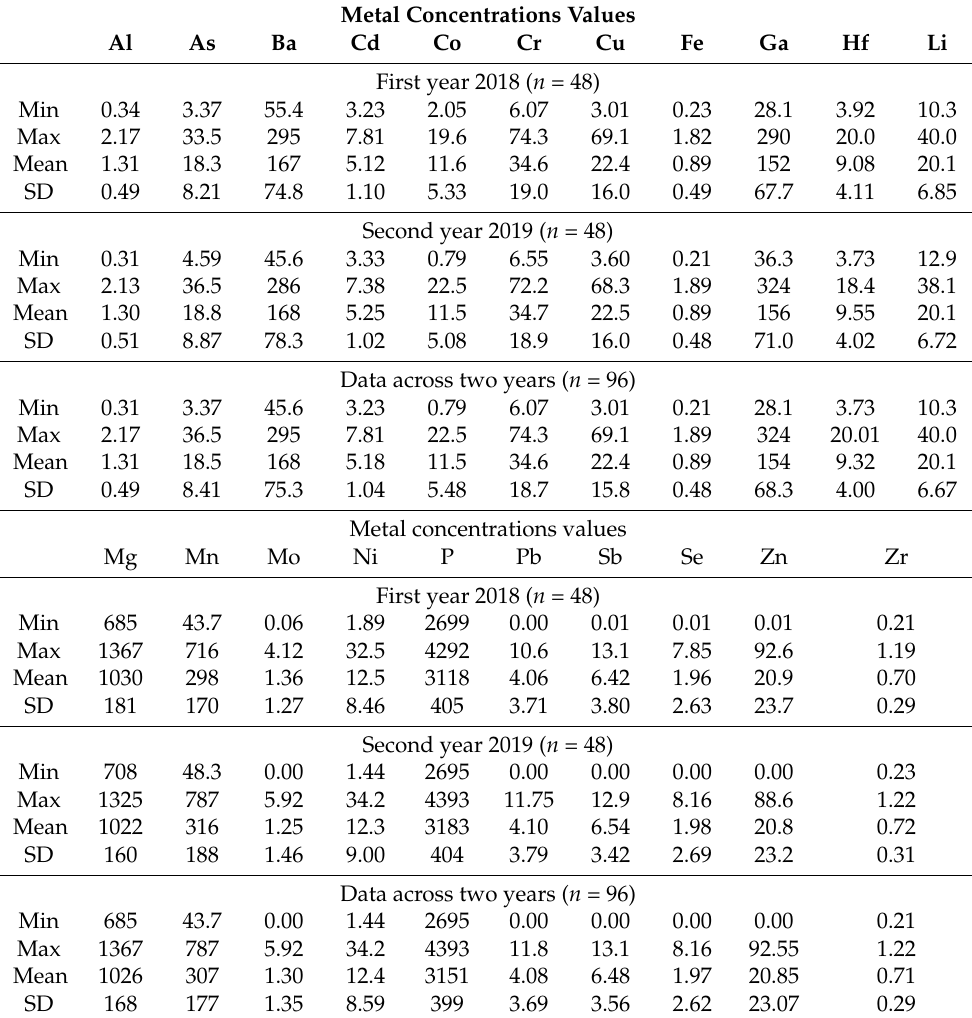
Table 2. Statistical description of metal concentrations in ppm, except for aluminium, iron, and zirconium which are in